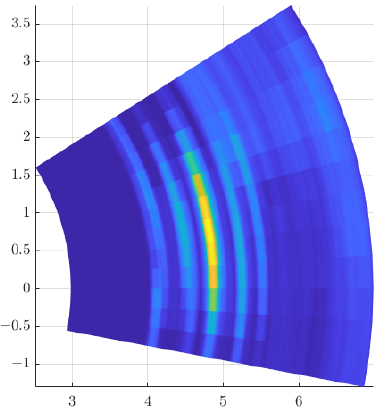
Figure 4. An example of mean filter application in pre-processing step. This method is based on ordering adjacent pixels and then applying the mean value for a specific filter size. The 5 × 5 pixels window was used for this processing case. [own source].